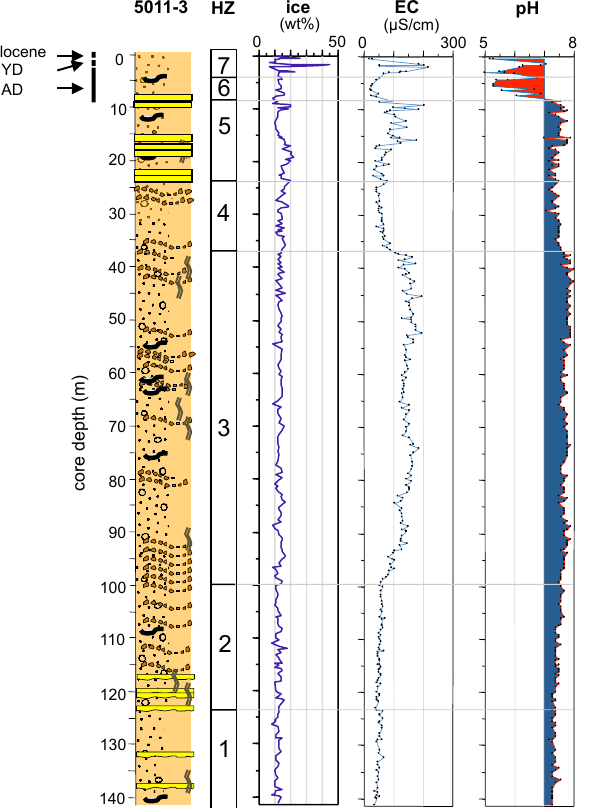
Figure 3. The lithological log of core 5011-3 with ice content, EC (electrical conductivity), and pH of the ground ice. The subdivision into hydrological zones (HZs) is based on the EC